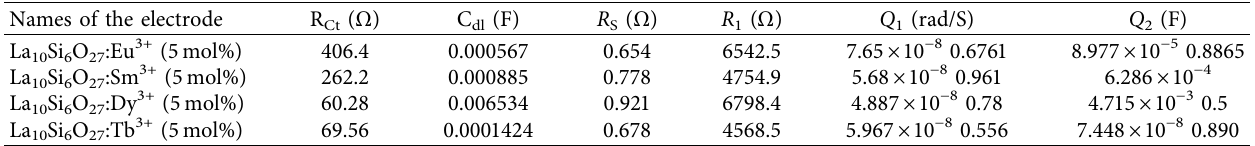
Table 4: Impedance parameters of different La circuit (Figure